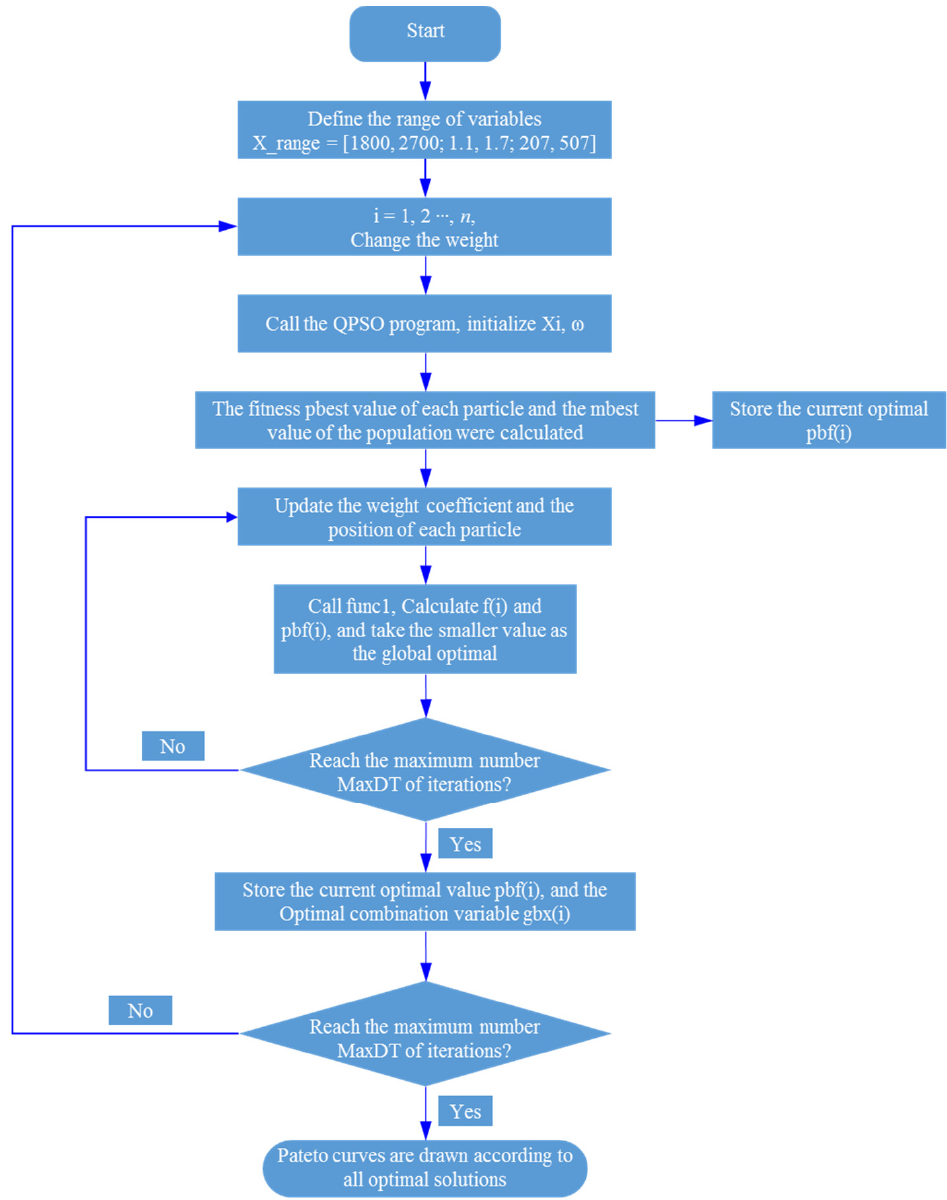
Figure 9. Flow chart of IMQPSO algorithm.